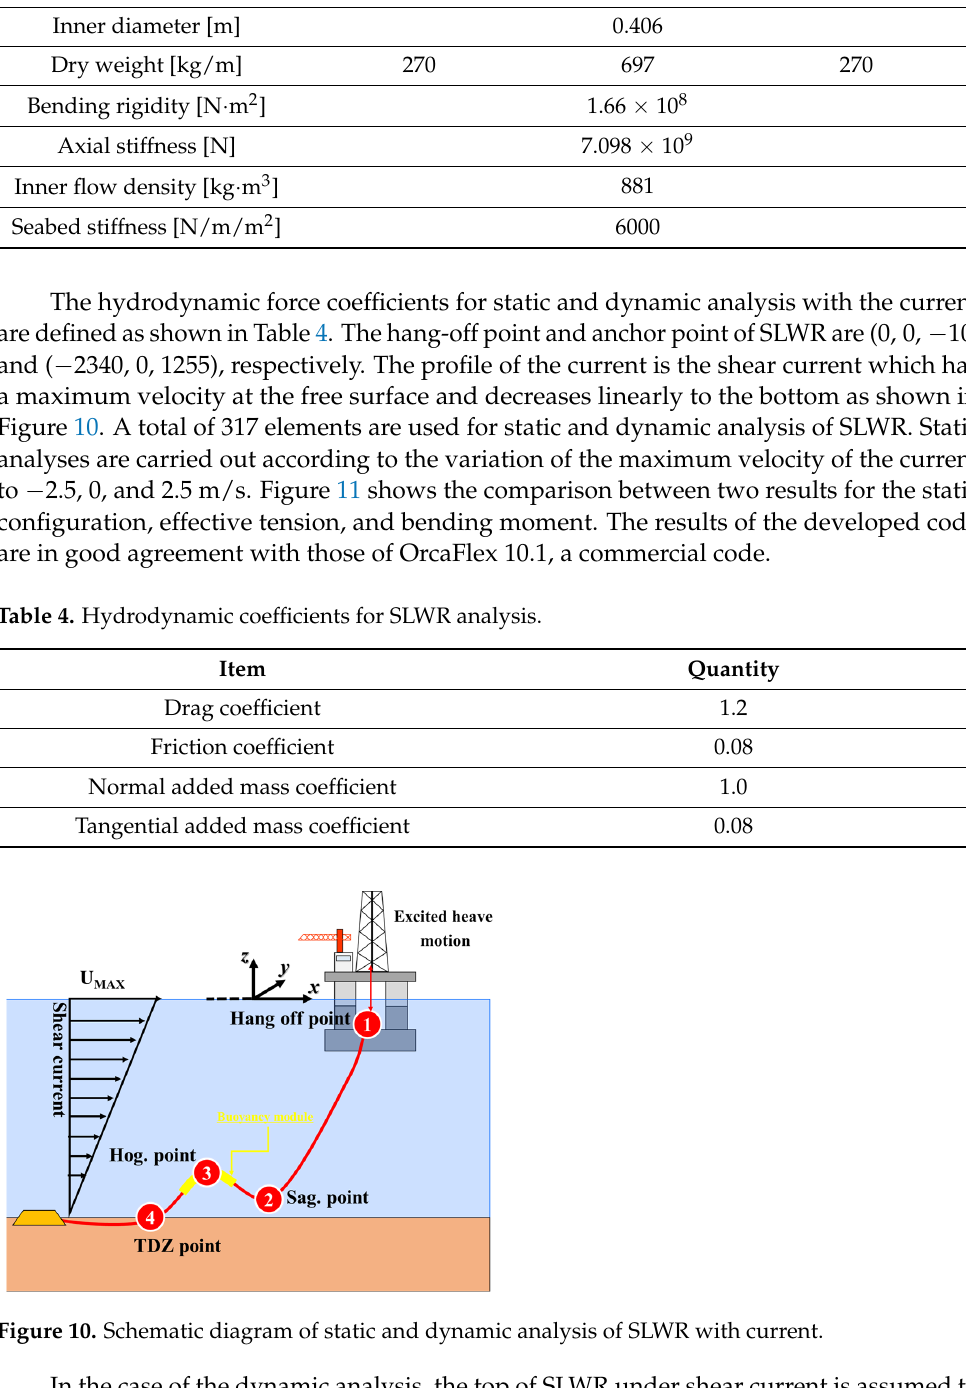
Table 3. Parameter of steel lazy wave riser [41].